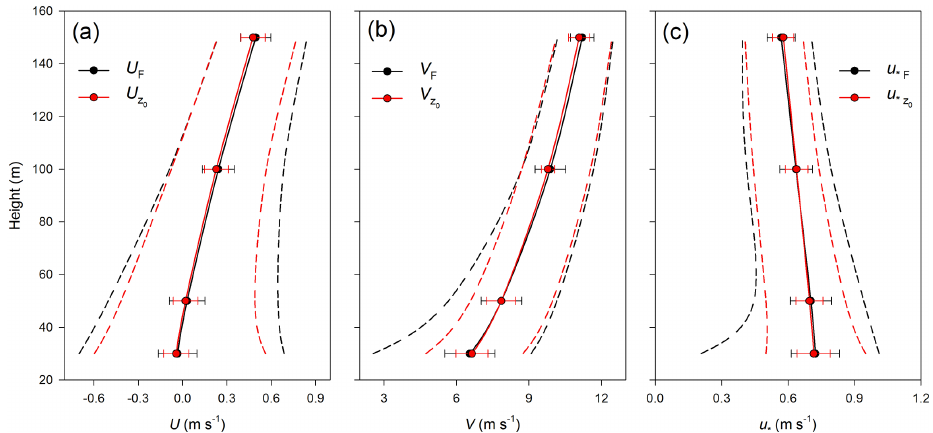
Figure 6. Average values of (a) eastward ( U ) and (b) northward ( V ) components of wind speed and (c) local friction velocity ( u ∗ ) in the area of interest at different heights over ground (30, 50, 100 and 150m) derived using the canopy drag (black) and the effective roughness (red) approaches. Bars denote standard deviations. Range of variables is indicated by dashed lines.